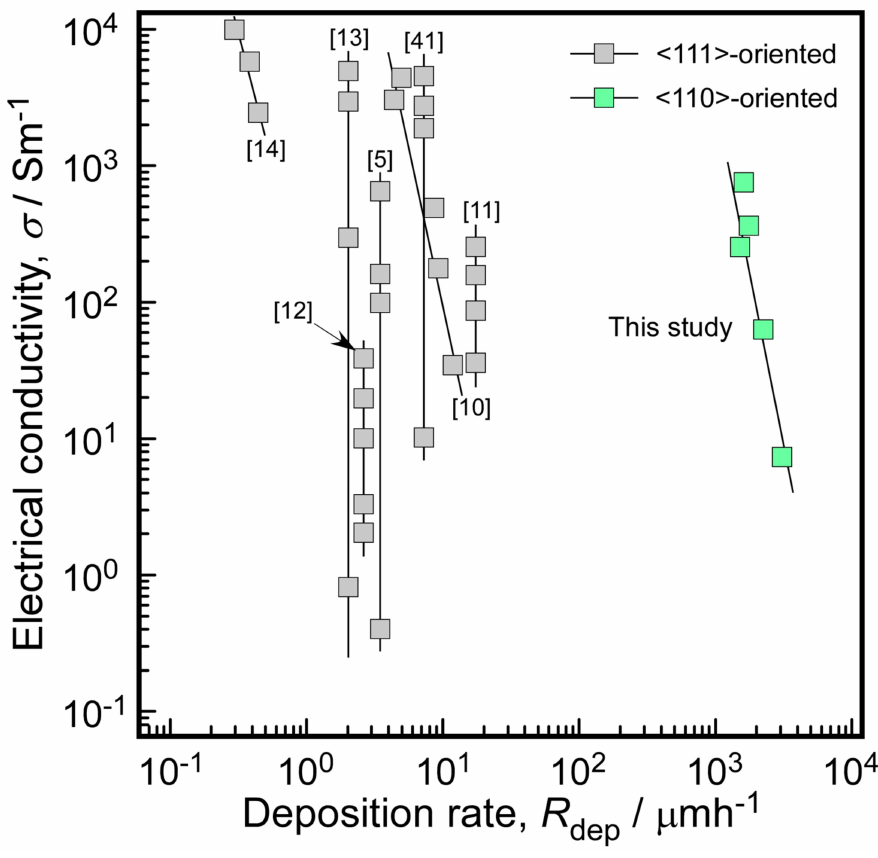
Figure 8. Comparison of electrical conductivities and deposition rates of N-doped 3C-SiC